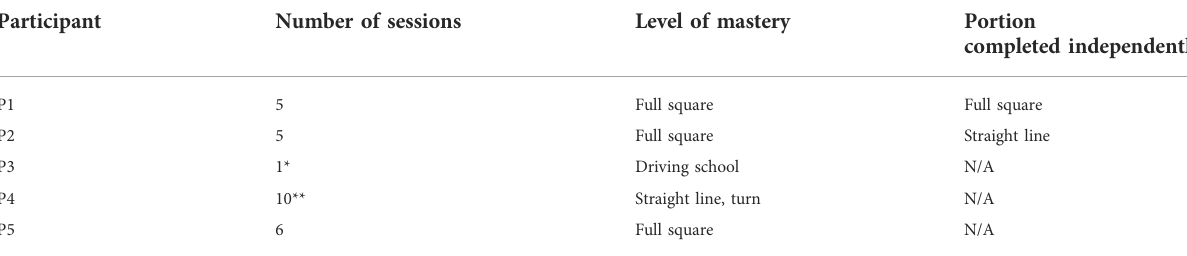
TABLE 2 Year 1, phase 1: participants ’